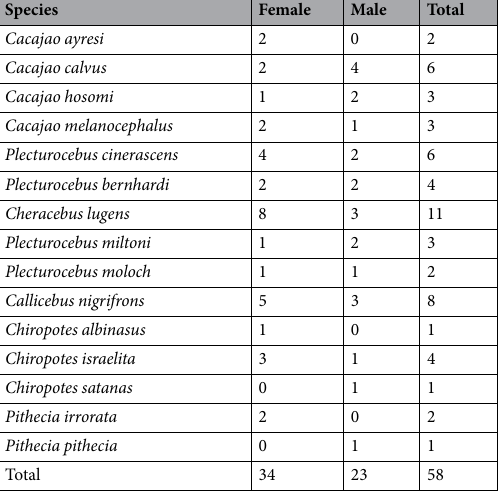
Table 3. List of species used in the molecular analysis of allelic types of Medium/Long visual